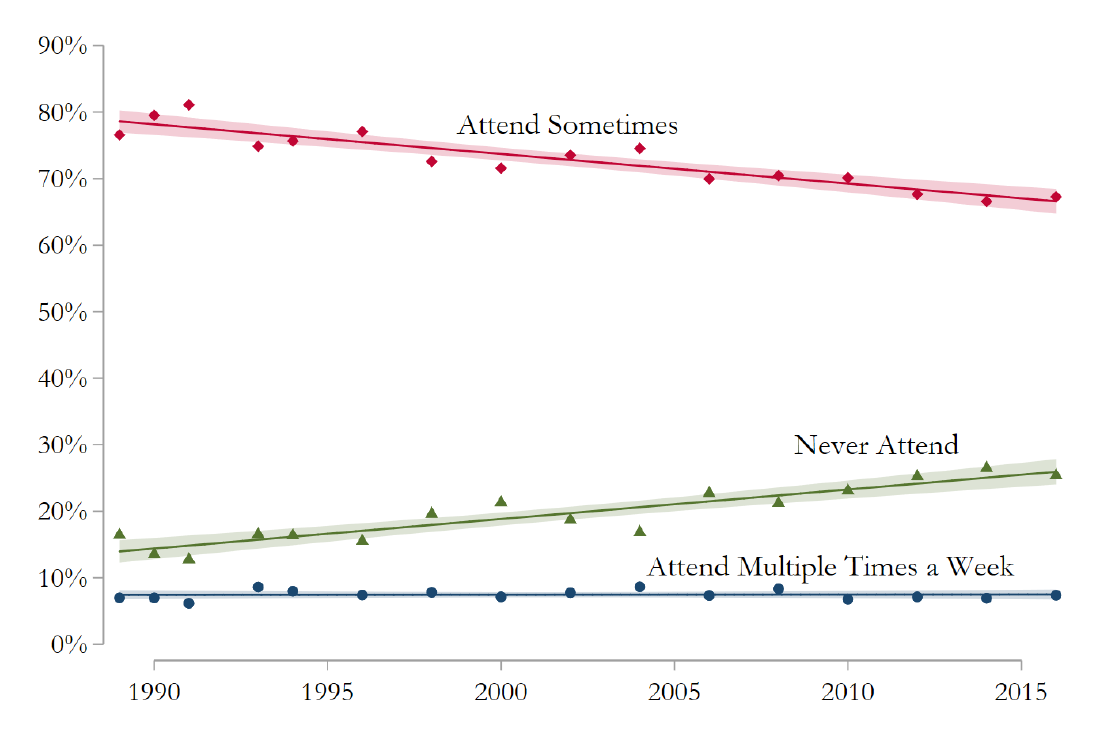
Figure 3: Religious service attendance frequency over time, General Social Survey. Source: General Social Survey, 1989 to 2016. Note: The nine GSS attendance response options are never = 1, less than once a year = 2, once a year = 3, several times a year = 4, once a month = 5, several times a month = 6, nearly weekly = 7, once a week = 8, and more than once a week = 9. “Attend sometimes” includes response options 2 through